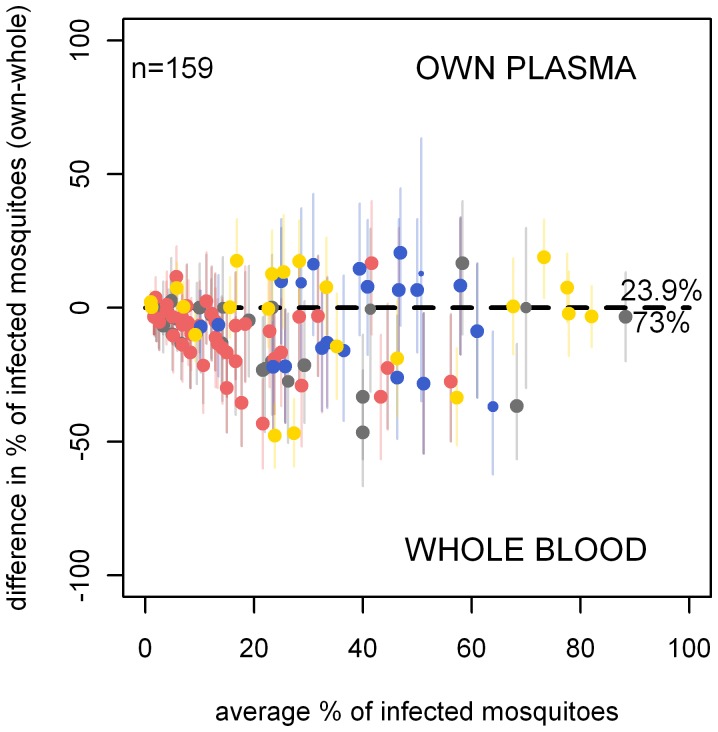
Membrane feeding with whole blood and with own plasma.The results are from 159 paired experiments. In 116 experiments (73.0%), the proportion of infected mosquitoes was higher in experiments with whole blood samples (i.e., without sample modulation) compared to serum replacement experiments where the blood pellet went through additional manipulation before being re-suspended with the gametocyte donor's own plasma. In 38 experiments (23.9%) the opposite was observed. Point size, shape and colour are as described in Figure 3. All experiments were performed in Cameroon.